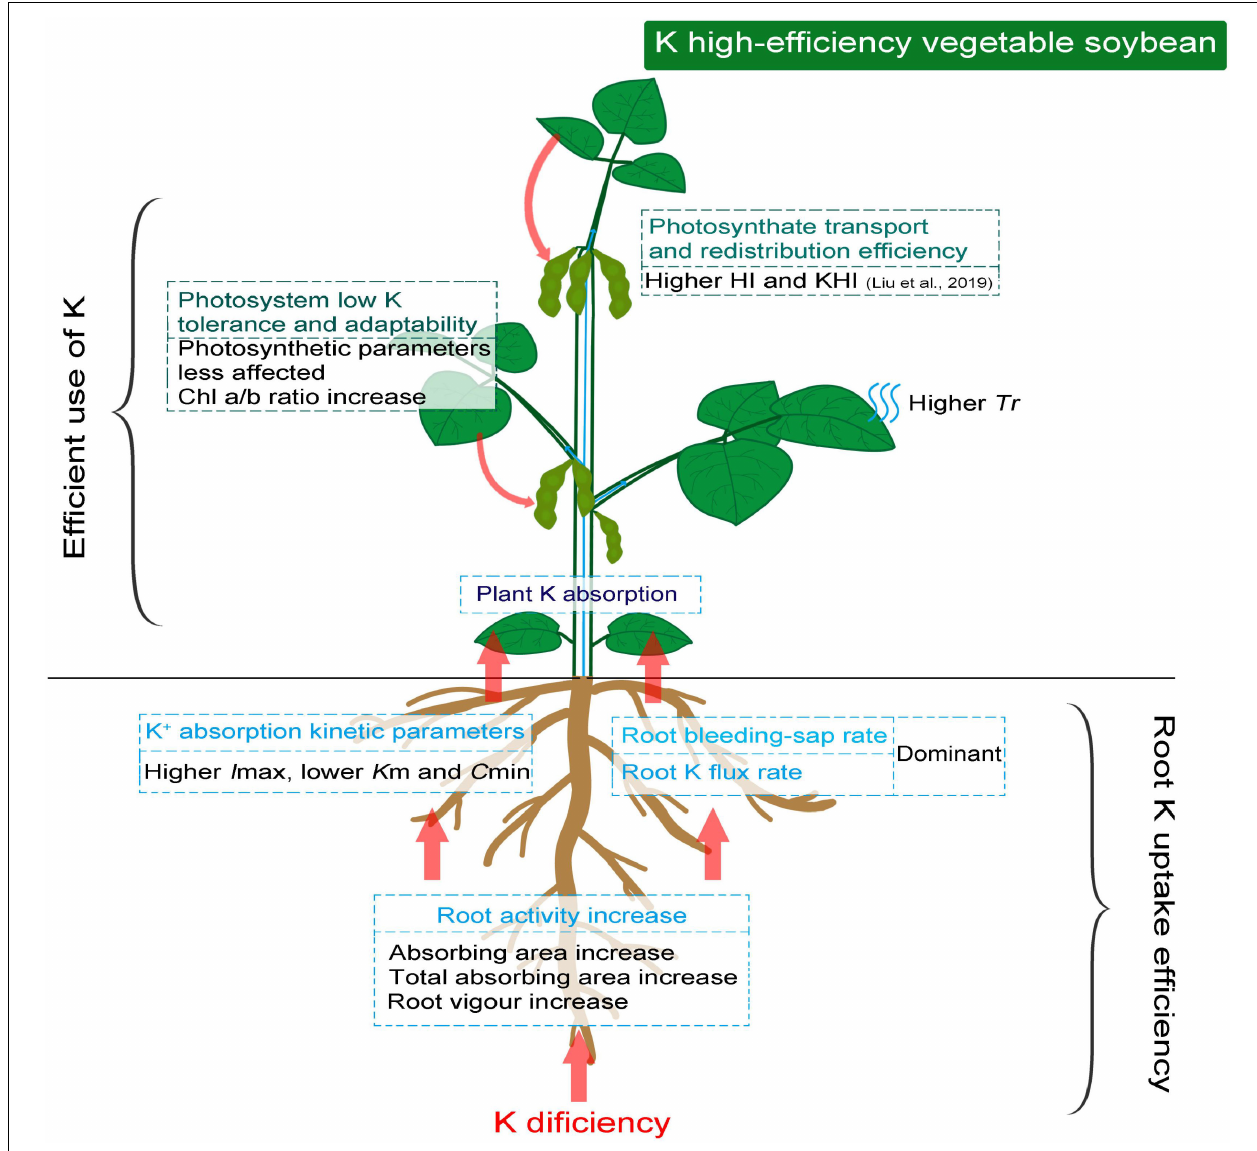
FIGURE 5 | Schematic diagram demonstrating efficient K absorption and photosynthetic assimilation in K high-efficiency vegetable soybean under low K